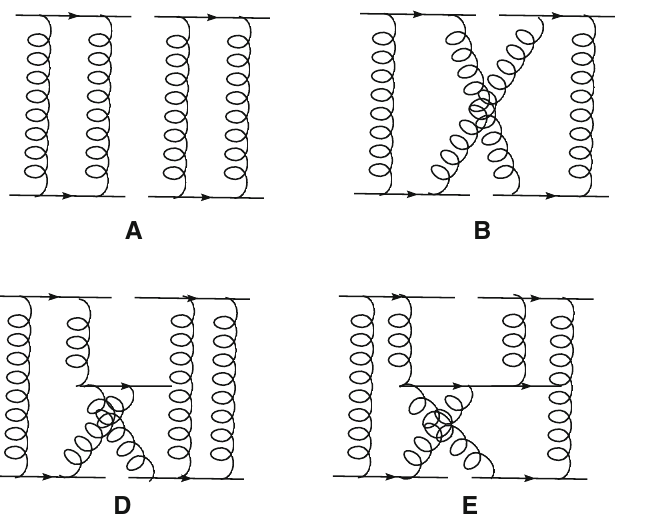
Fig. 1 Lowest order diagrams which involve interaction of four pomerons α s N c smaller than D B , C .